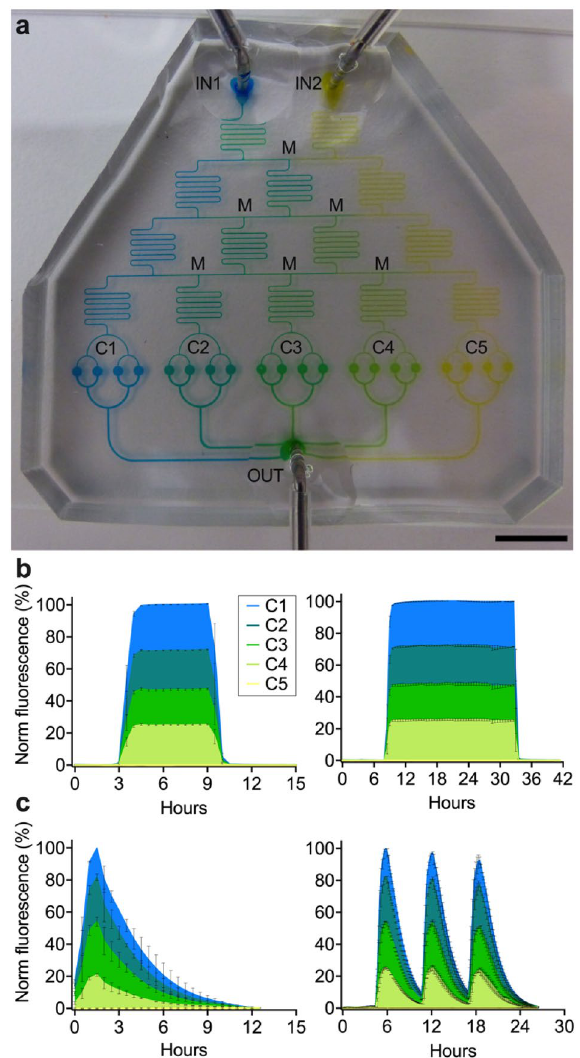
Figure 3. Characterization of gradient formation in the five-condition platform. ( a ) Picture of the five- condition device filled with dyes from two separate inlet ports (IN1 and IN2) of the FL, in the absence of CL. Blue and yellow dyes form a color gradient in the dilution tree, via serpentine mixers (M), reach five independent groups of four chambers (C1–C5), and flow into a common outlet (OUT). Scale bar 10 mm. ( b , c ) Formation of gradients through progressive mixing of a FITC solution (100 µM) injected into IN1 with a non-fluorescent solution injected into IN2. Mean fluorescence is measured from each culture chamber. Steady ( b ) and pulsing ( c ) gradient patterns of different duration are shown. Filled lines and error bars indicate mean ± SEM ( N = 2 or 4). Colors indicate different groups of chambers, color coded as in ( a